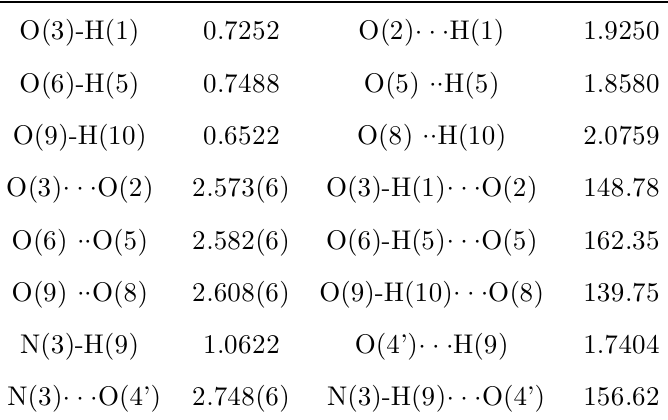
Table 6 Hydrogen bonding (¸A, deg.) in the crystal of 4